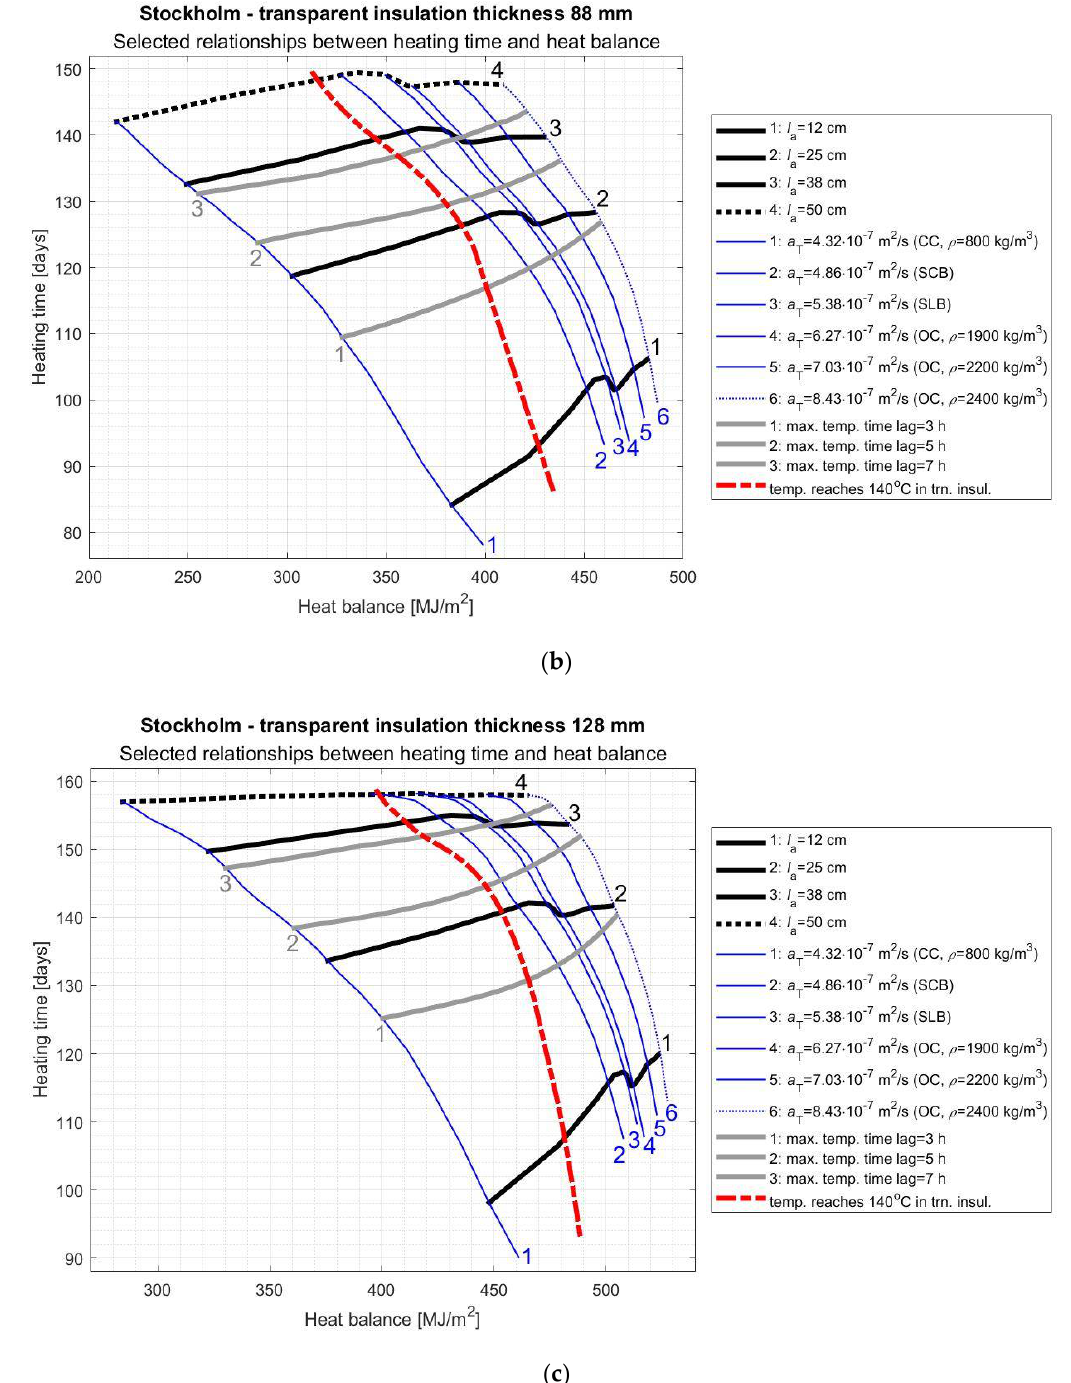
Figure 8. Relationship between the heating time and heat balance for the AL depending on its selected most important features. TI thickness: ( a ) 48 mm, ( b ) 88 mm, ( c ) 128 mm. Location: Stockholm.